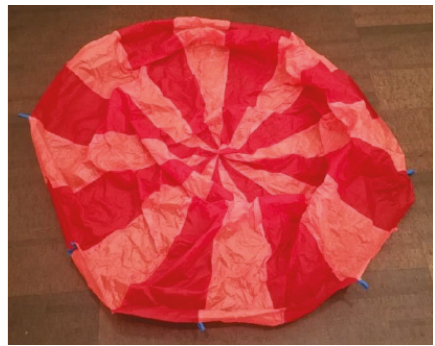
Figure 10: The 16-segment, dome-shaped parachute.